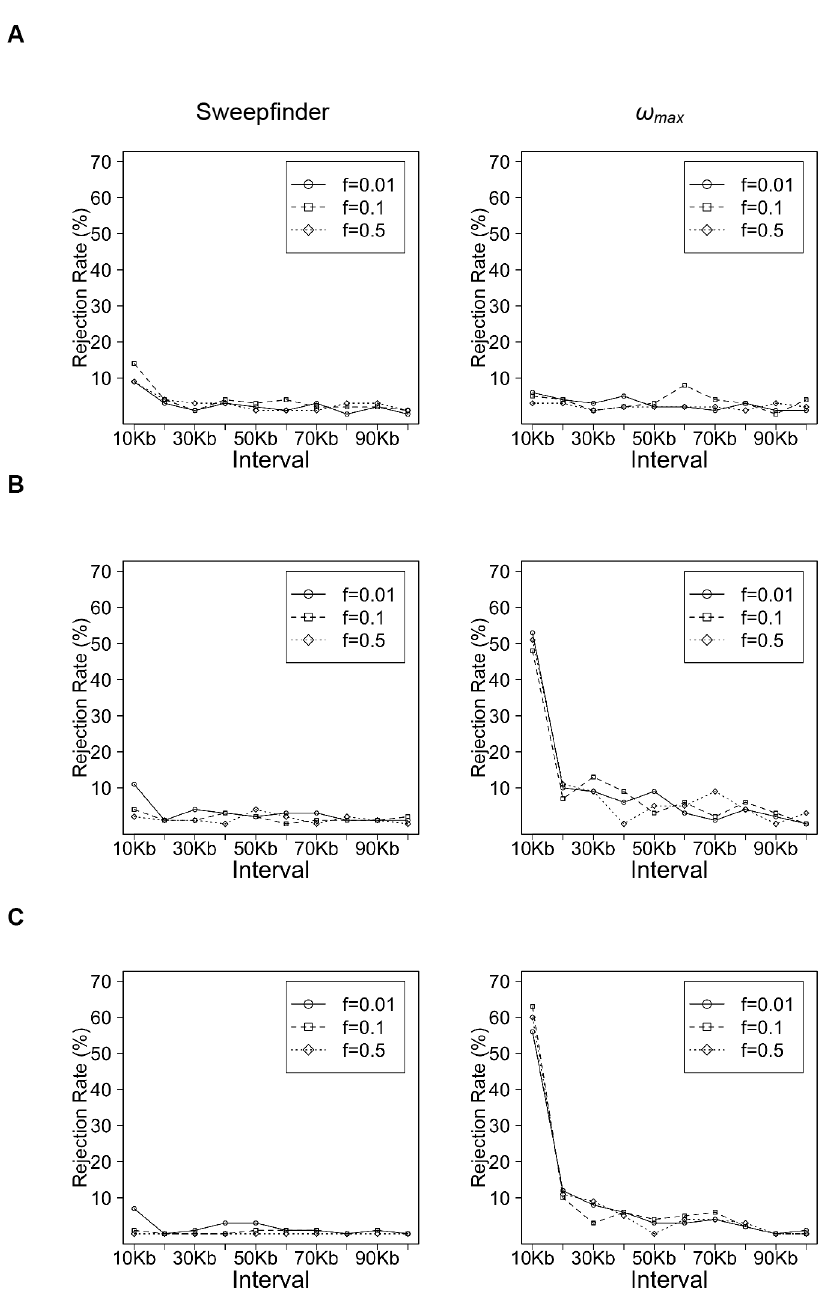
Figure 3. The fraction of simulated replicates rejecting neutrality by Sweepfinder and v max , with varying bottleneck severity. Simulations with ancestral population size equal to (A) 10 4 , (B) 10 5 and (C) 10 6 . Selection strength ( s =0.01), time since fixation ( t =0.1), and time since bottleneck ( t r =0.1) are fixed, but bottleneck severity ( f ) varied from 0.01 to 0.5.